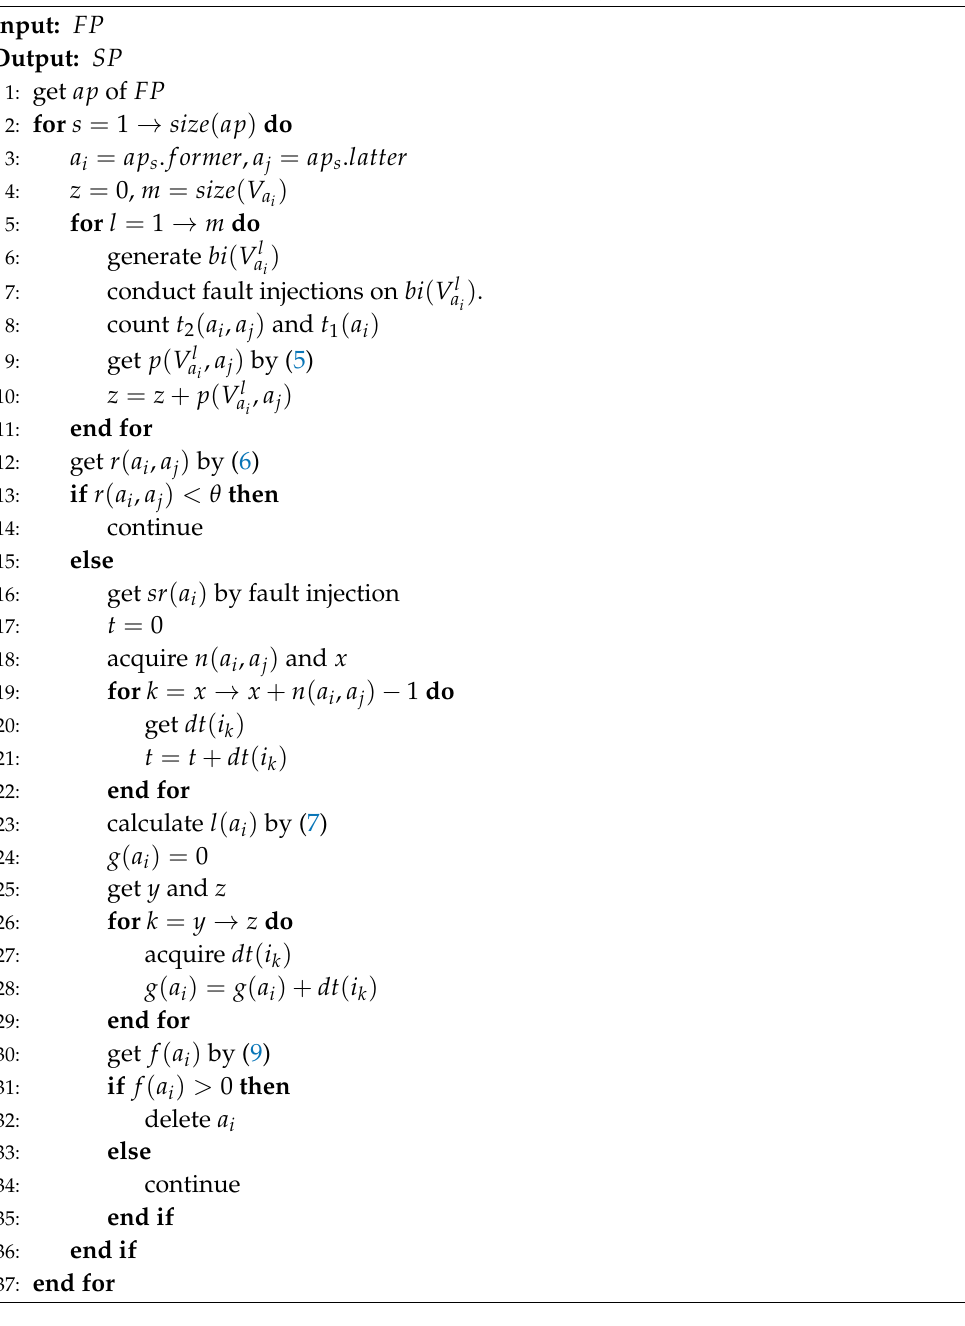
Algorithm 2 Screening assertions for neighbouring program